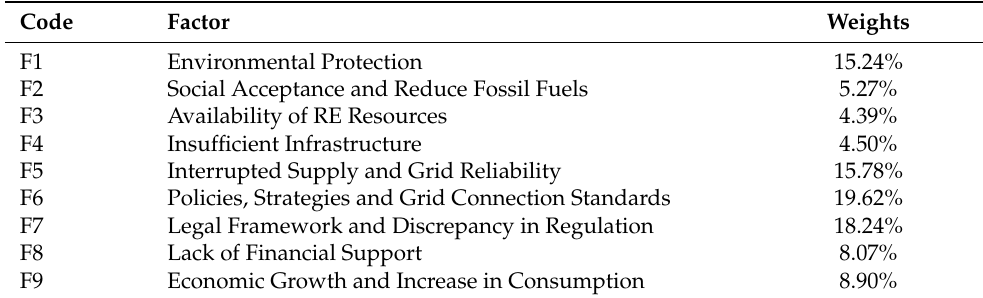
Table 8. Weight of The Factors That Affect UAE’s Renewable Energy